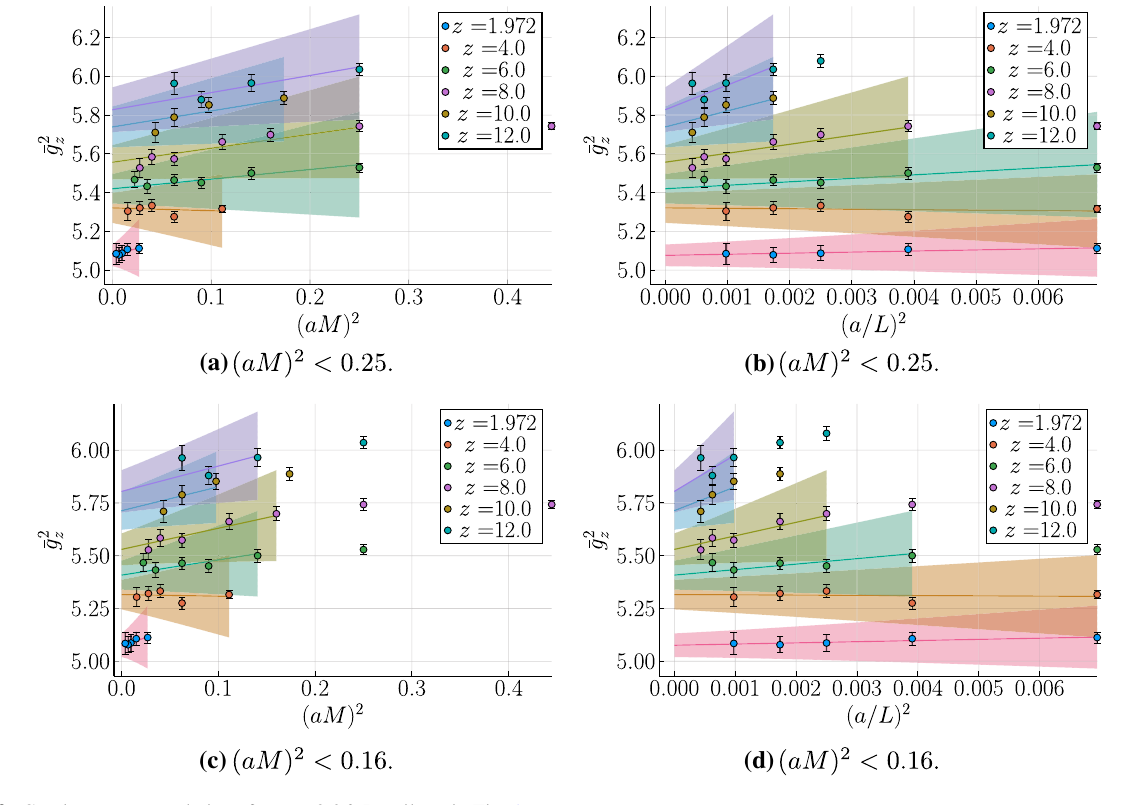
Fig. 2 Continuum extrapolations for c = 0 . 36. Details as in Fig.